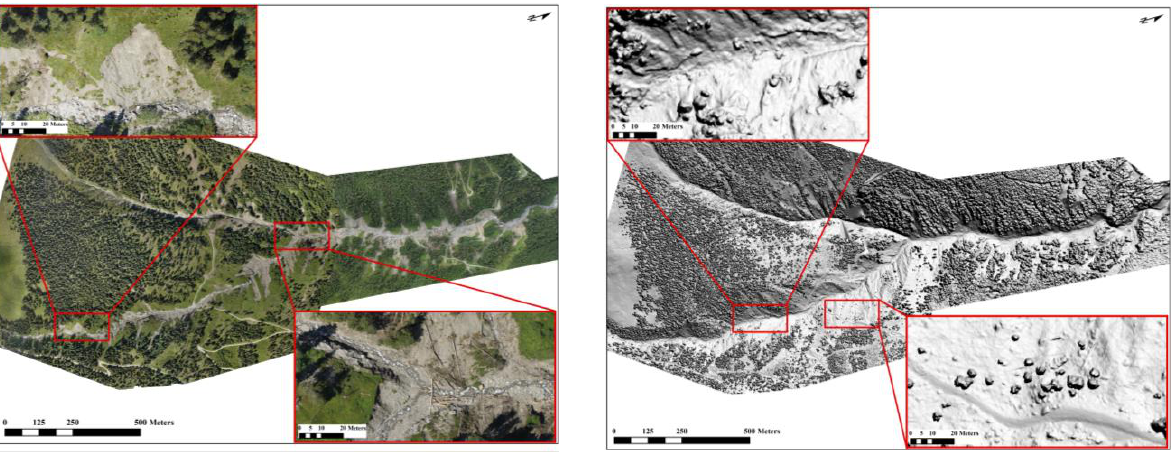
Figure 4. Results from the photogrammetric processing – orthophoto (left) and digital surface model (right) of the